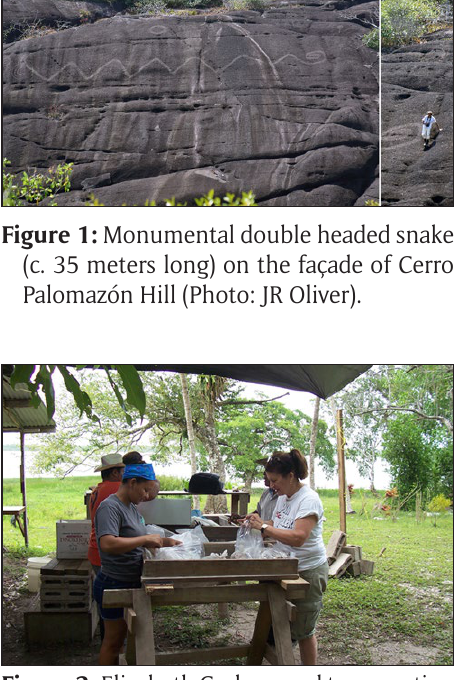
Figure 2: Elizabeth Graham and team sorting collections for rehousing at Lamanai, Belize (Photo: Elizabeth